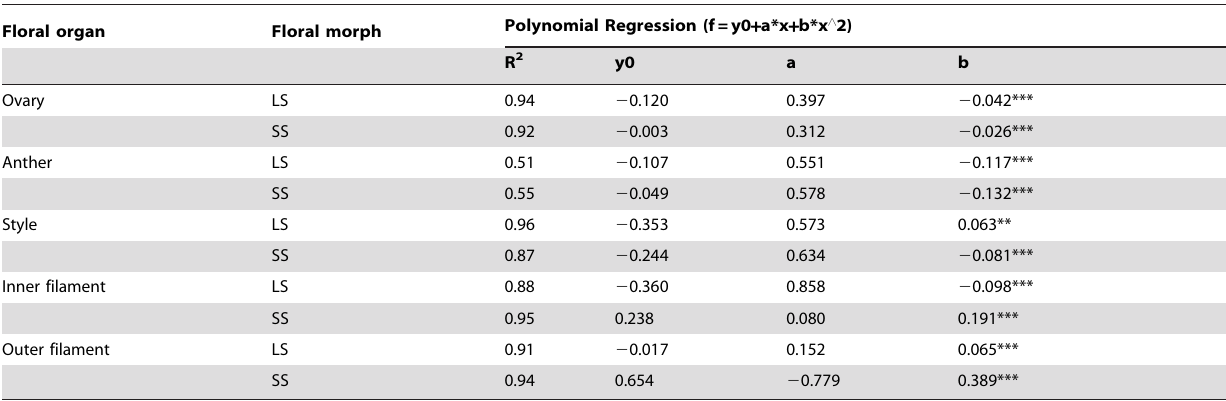
Table 3. Quadratic regression of relative growth rates of floral organs against bud length for long-styled (LS) and short-styled (SS) flowers of Polygonum